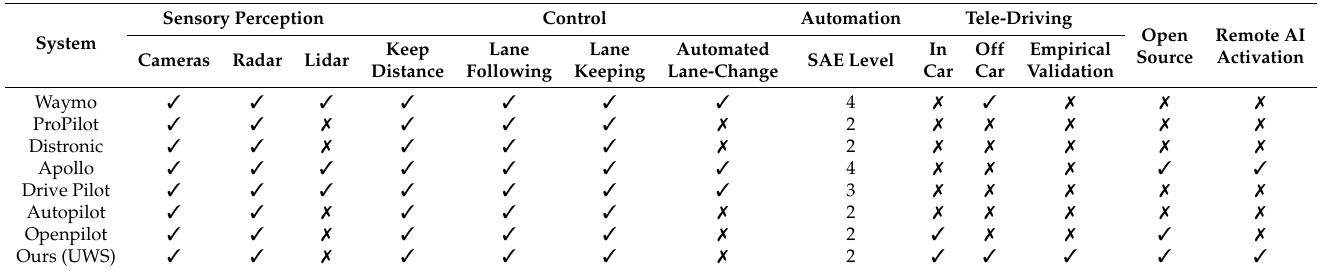
Table 1. Characteristics and comparison of different autonomous driving car systems. (cid:51) denotes that the capability is available in the system and (cid:55) denotes that it is